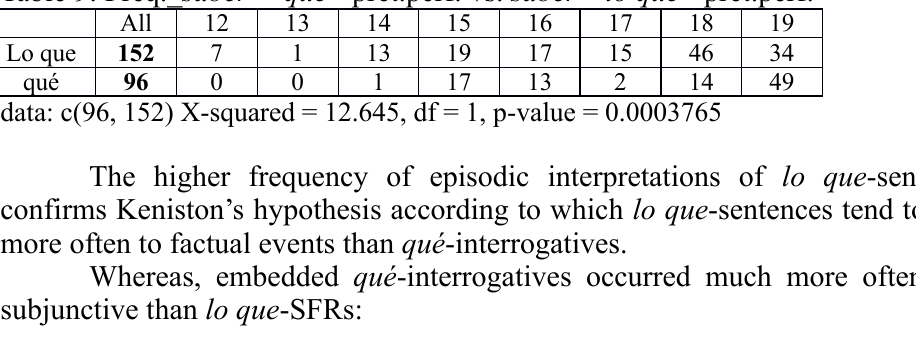
Table 9: Freq._ saber + qué +pret.perf. vs. saber+ lo que +pret.perf. All 12 13 Lo que